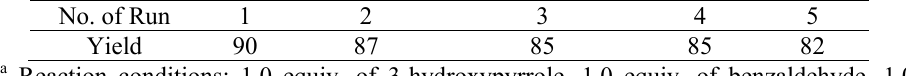
Table 1 . Reusability of [pmim]HSO